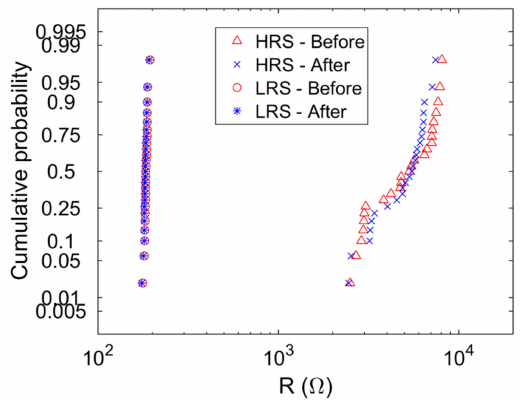
Figure 8. Cumulative distributions of the resistance values for a single RRAM (2 × 2 µ m 2 ) before and after a single laser pulse. The spot size is 3 µ m.